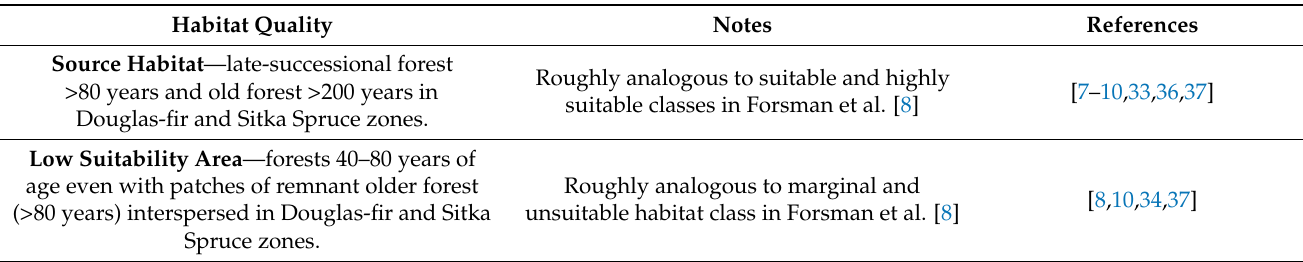
Table 1. Summary of information available to define and map habitat for red tree voles ( Arborimus longicaudus ) in the evaluation area in Oregon and California,